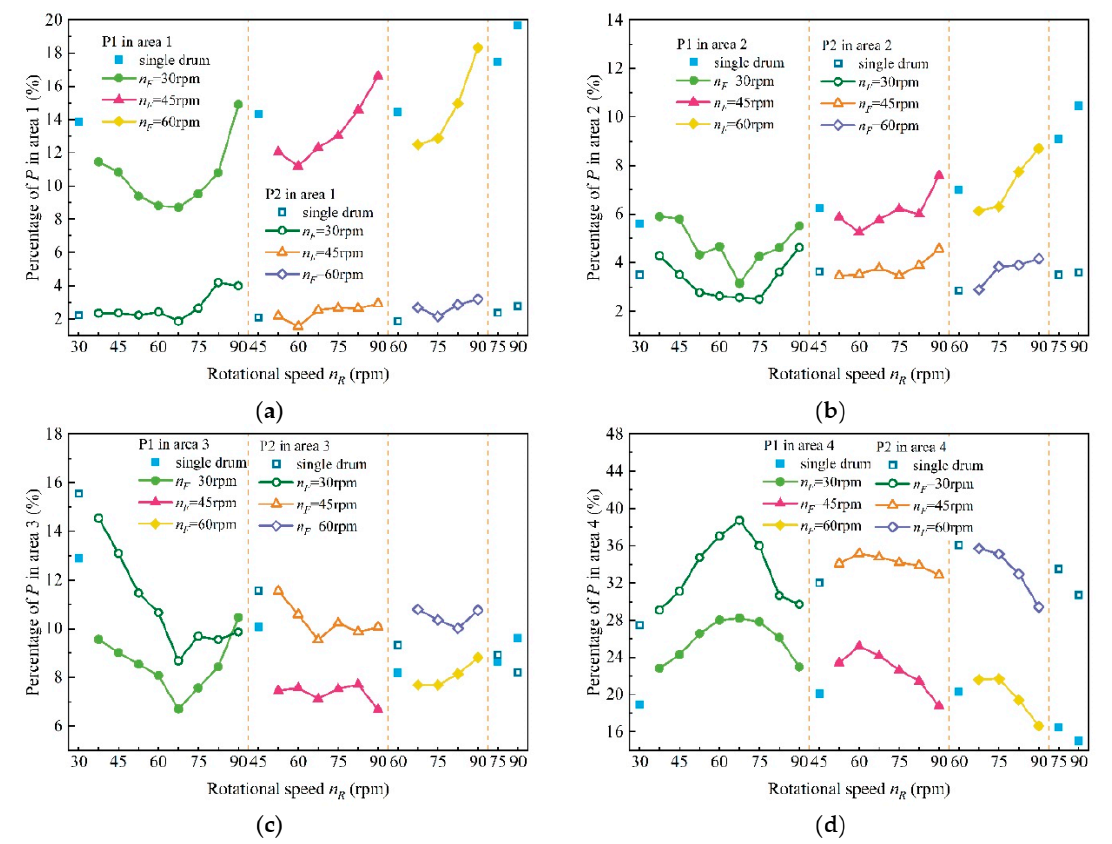
Figure 12. The distribution of P1 and P2 particles in different statistical areas: ( a ) statistical area 1; ( b ) statistical area 2; ( c ) statistical area 3; ( d ) statistical area